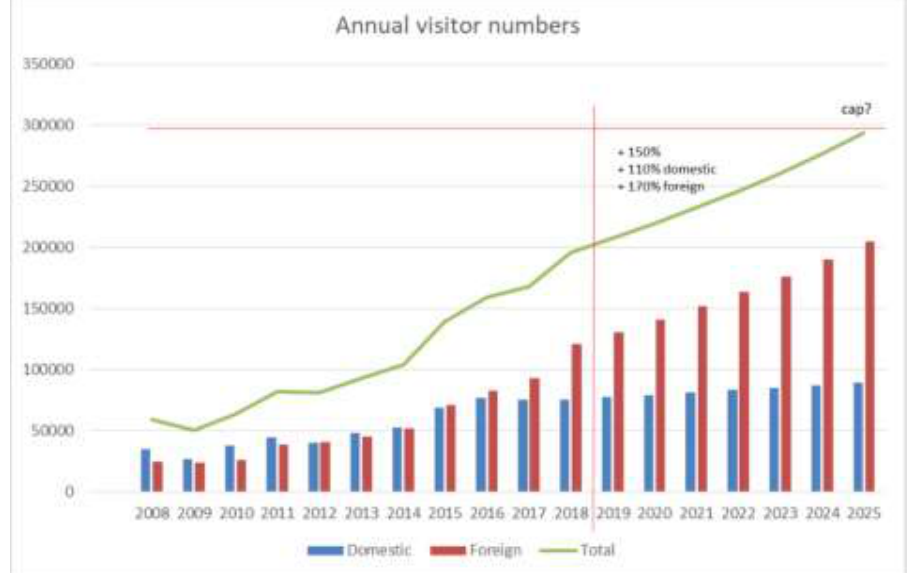
Figure 9: Projected growth in visitor numbers 2018-2025 To support this assessment, between 2013 and 2017 the number of foreign visitors to the region grew 17% on average annually 22 , whilst domestic visitors grew at the slower, but still significant, rate of 11%. Such trends accord with the observations made earlier in this IMP. These tourists (foreign visitors) can be broken down into two main